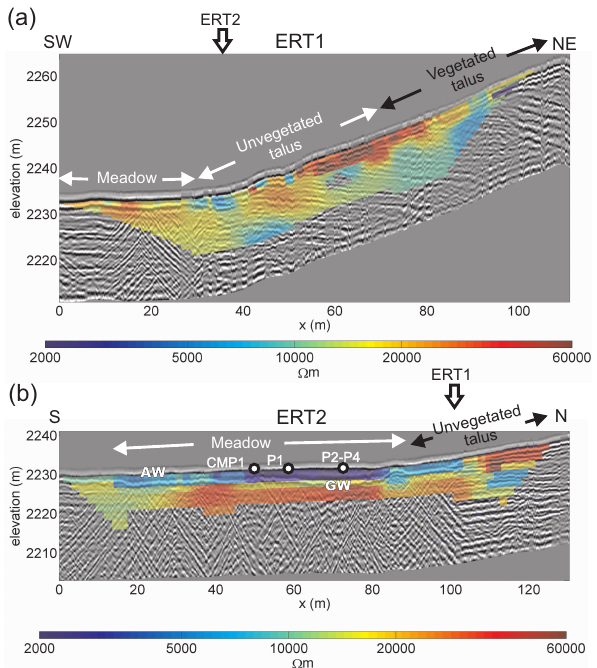
Fig. 6. As for Fig. 4, but with the corresponding inverted electri- cal resistivity tomograms ERT1 and ERT 2 overlain onto the GPR cross-sections. ERT model cells with DOI values > 0.2 are not plot- ted (see text for explanation).